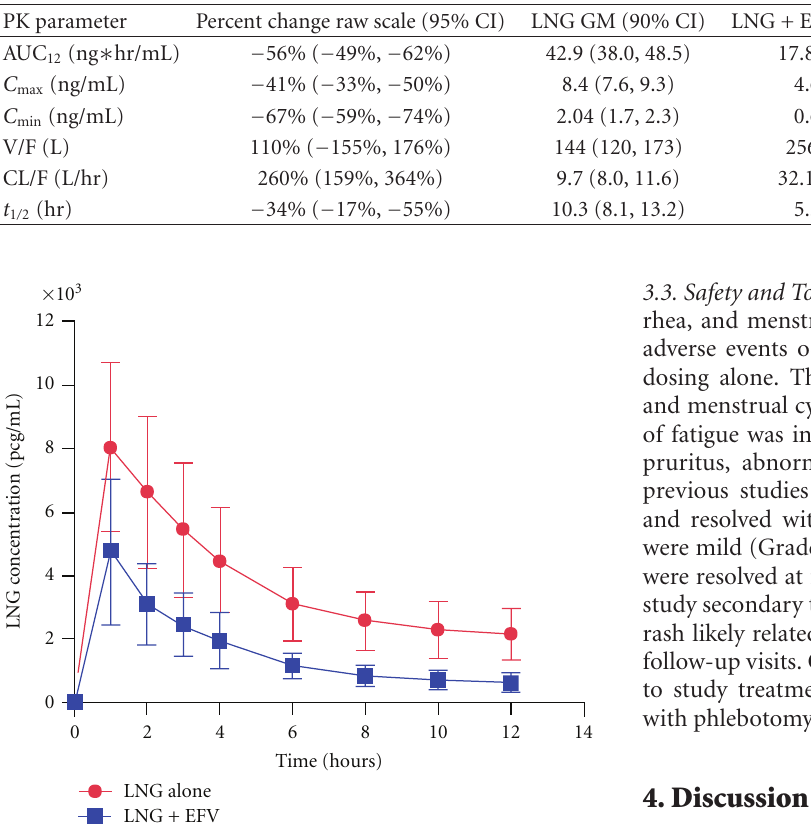
Table 1: Estimated LNG PK parameters.